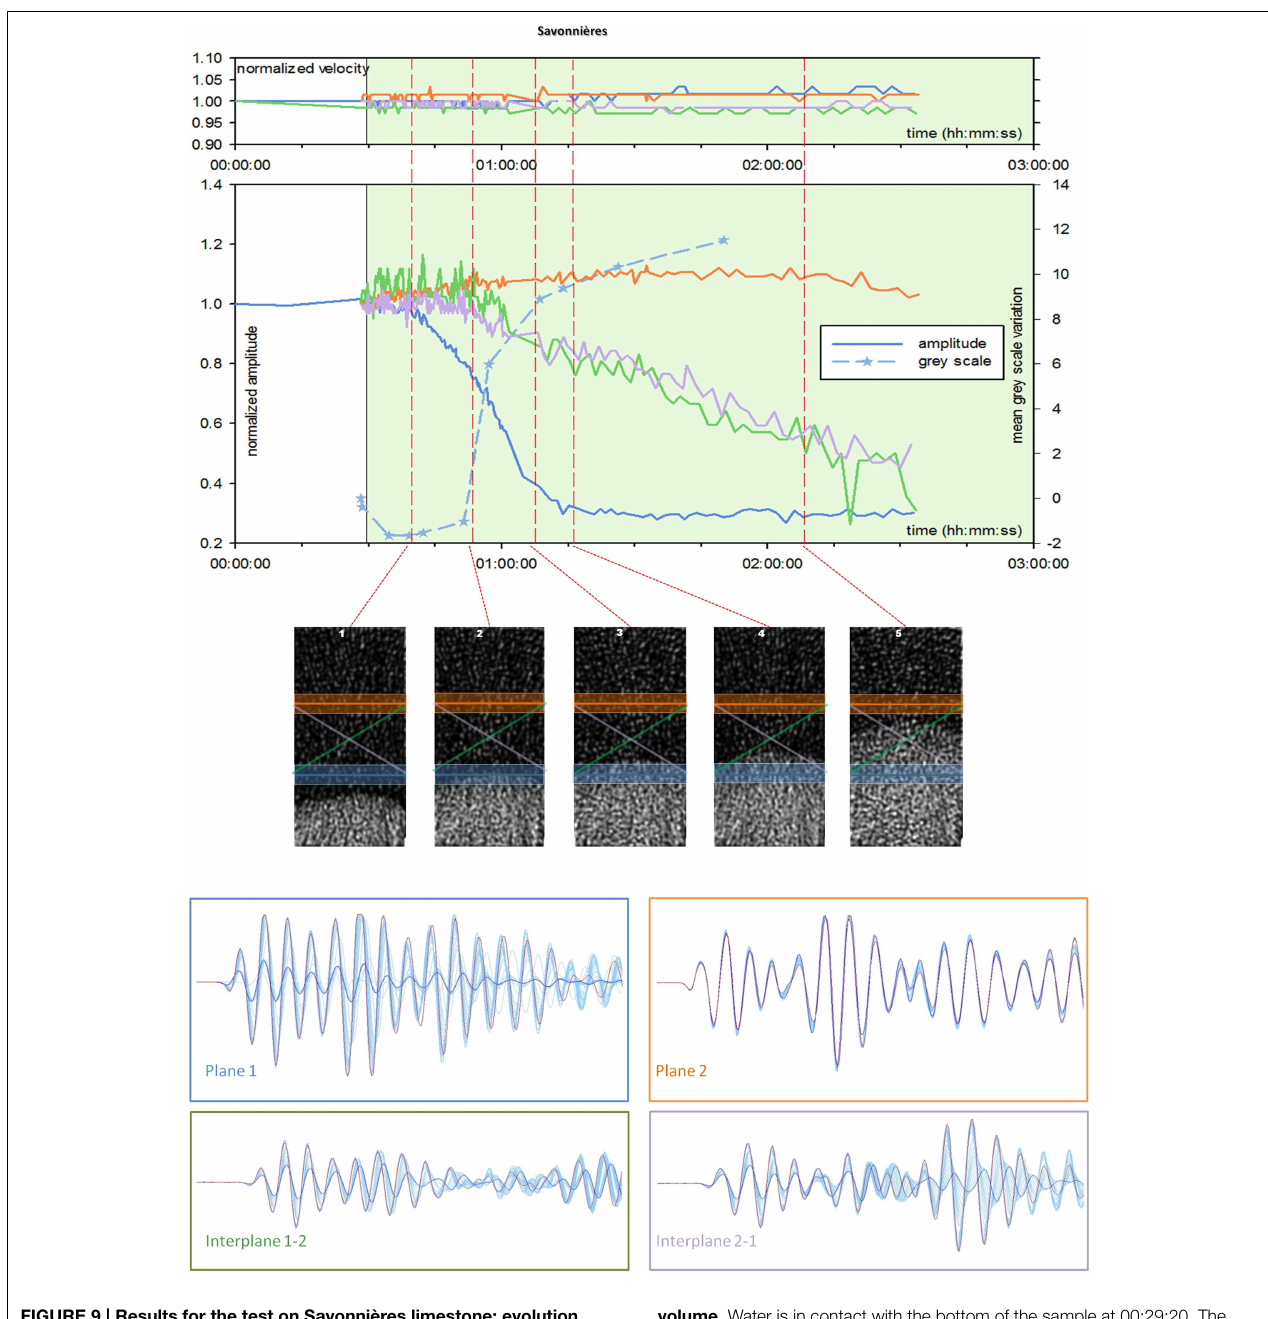
volume. Water is in contact with the bottom of the sample at 00:29:20. The lower part of the figure is a superimposition of transmitted signals during the test for all planes and interplanes (the first waveform obtained on the dry sample is displayed in red and the last one is displayed in dark